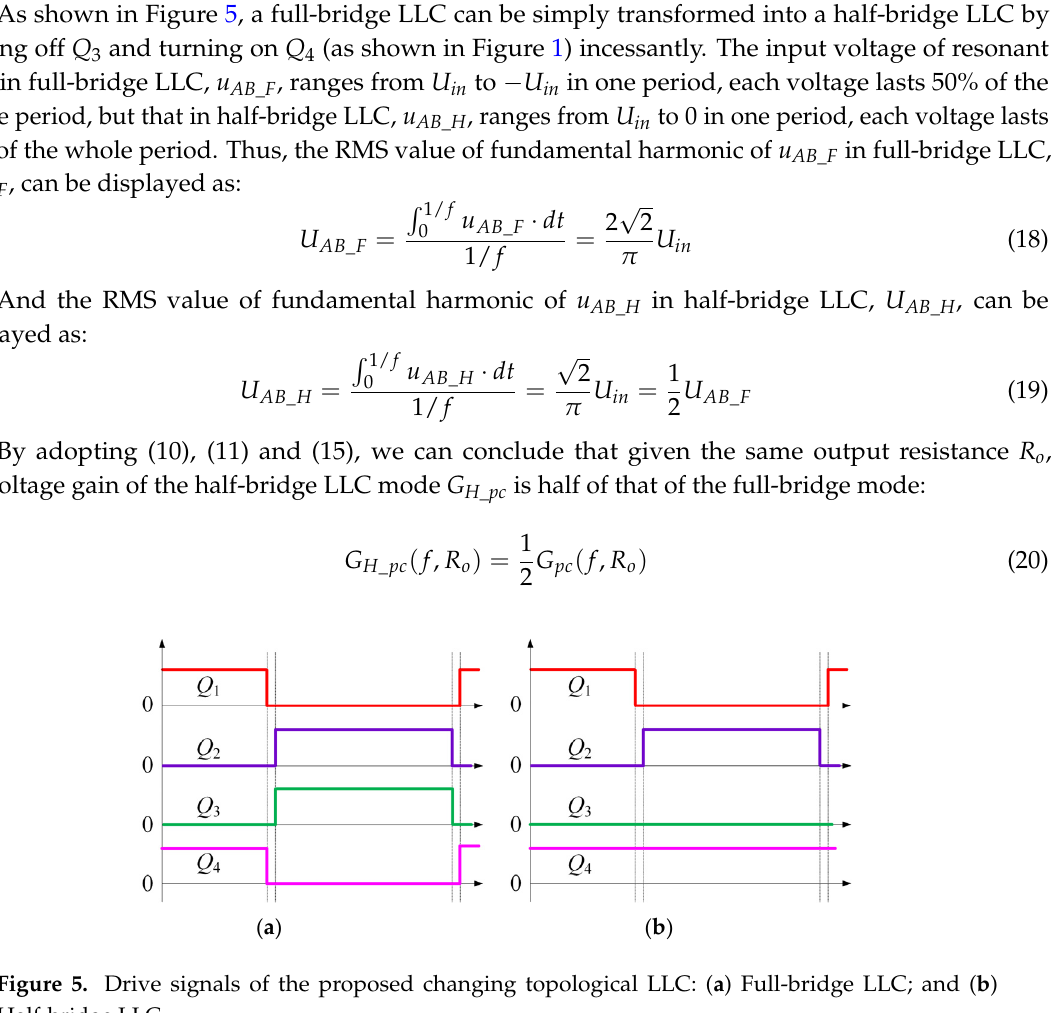
Figure 6. Voltage gain curve of half-bridge LLC.